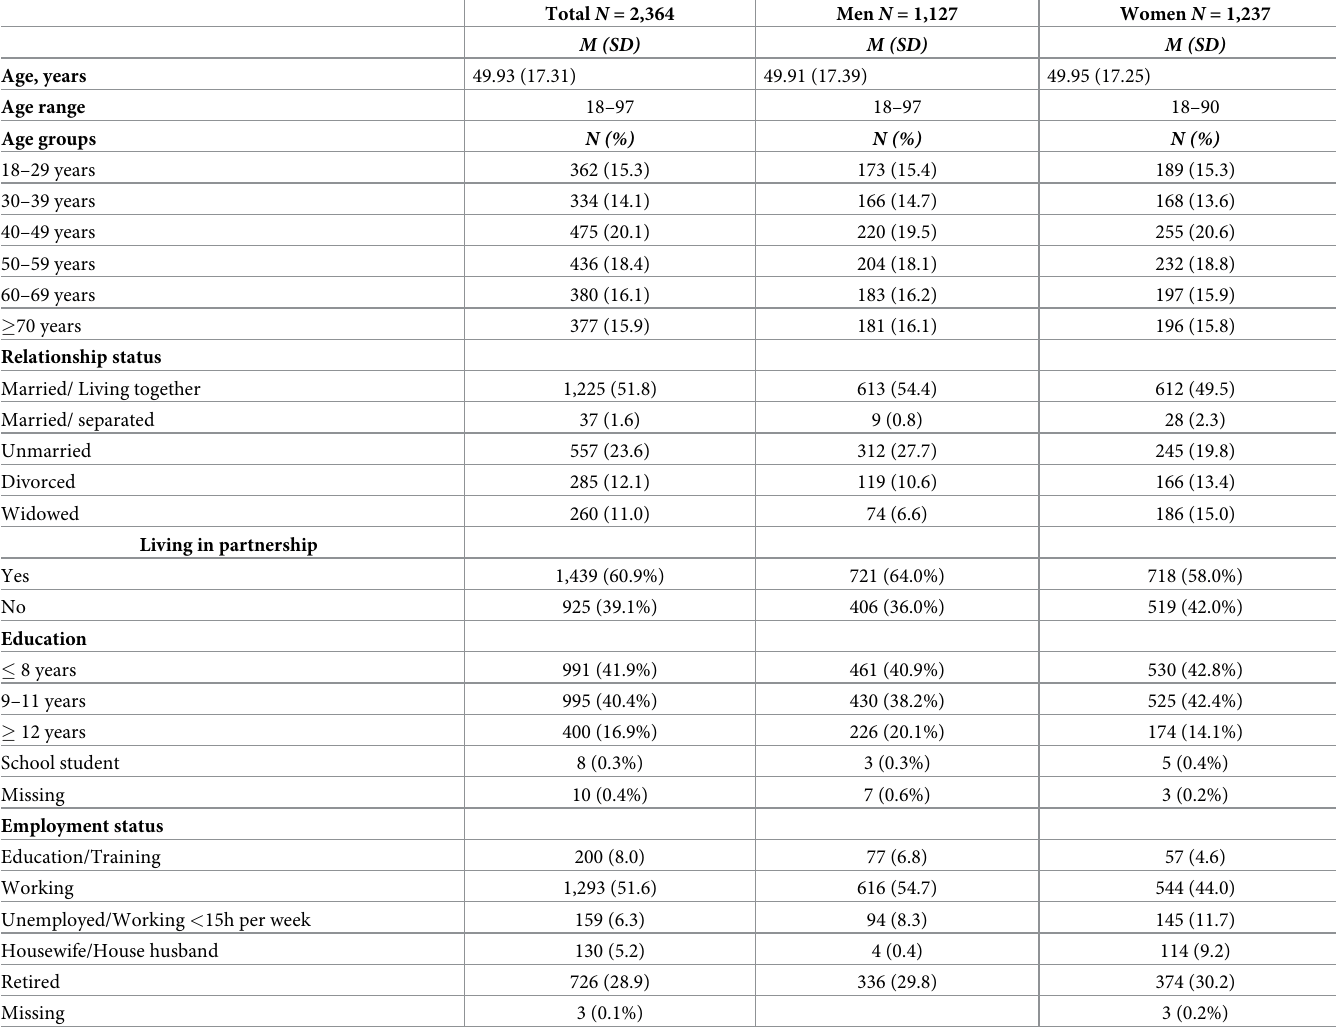
Table 1. Sociodemographic characteristics of the study